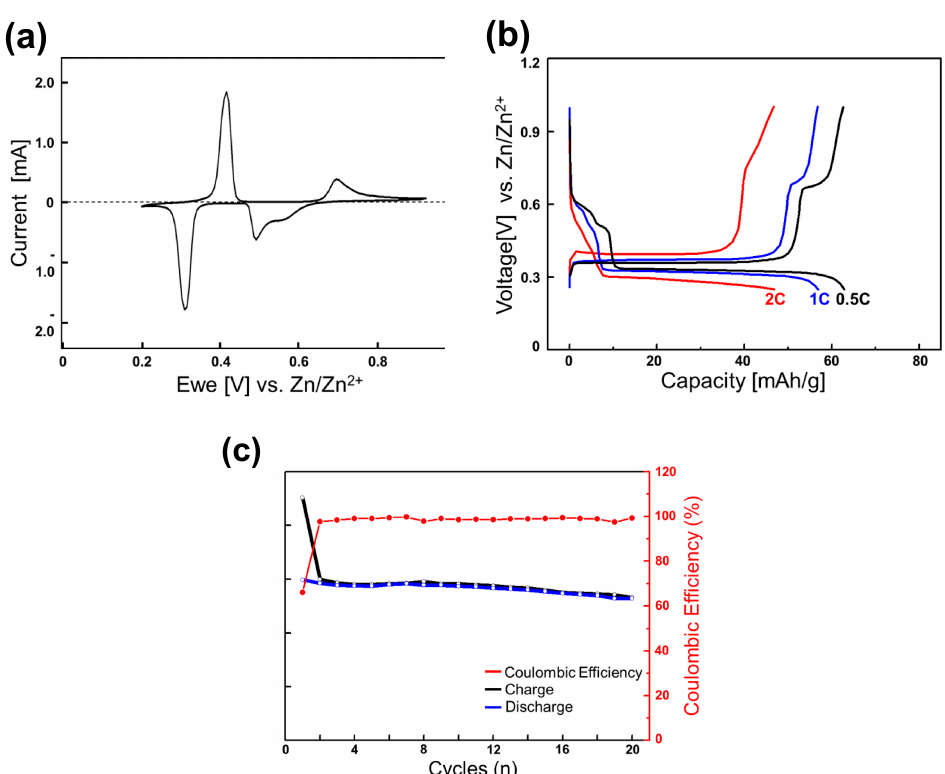
Figure 2. ( a ) Cyclic voltammograms of the Mo 6 S 8 electrode for the initial cycle at 0.05 mV s − 1 with zinc metal as the counter and reference electrode in 0.1 M ZnSO 4 aqueous electrolyte; ( b ) reversible discharge-charge cycles at various C rates (the second cycle); and ( c ) cycling performance at 0.1 C rate.